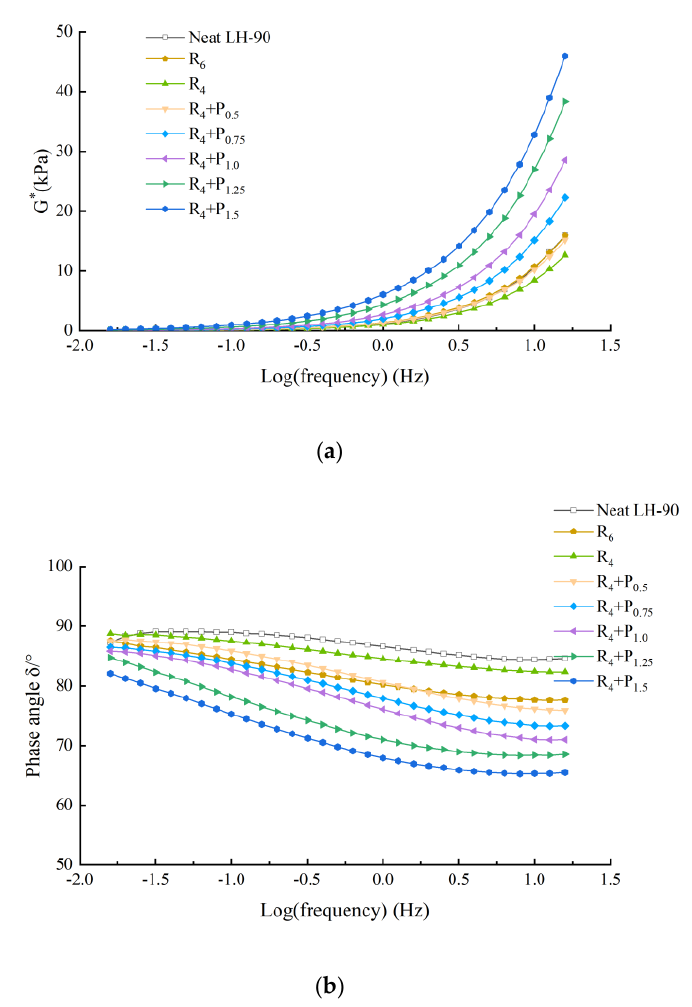
Figure 8. Complex modulus and phase angle master of compound PPA–SBR modified binders of LH– 90# asphalt: ( a ) Complex modulus-Log(frequency) results; ( b ) Phase angle-Log(frequency)